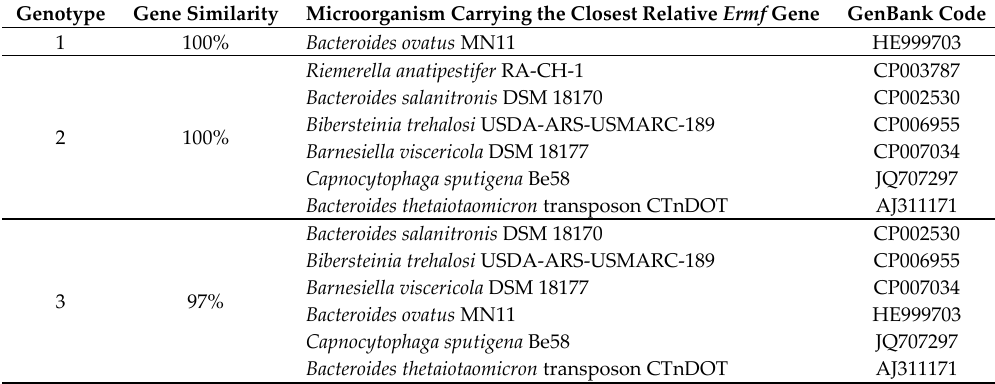
Table 2. Identification of the major ermF genotypes in the WWTP examined.